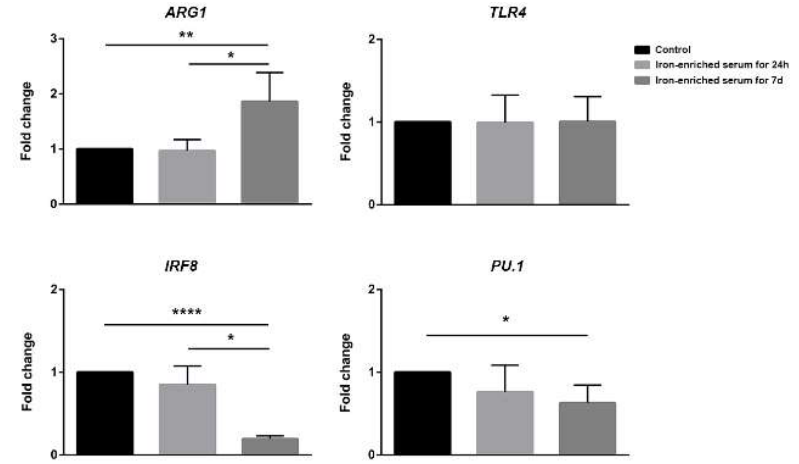
Figure 6. Gene expression analysis of ARG1, TLR4 , IRF8, and PU.1 in control, iron-enriched medium for 24 h or seven days cells. mRNA was isolated 6 h post LPS exposure. * p < 0.05, ** p < 0.01, **** p <